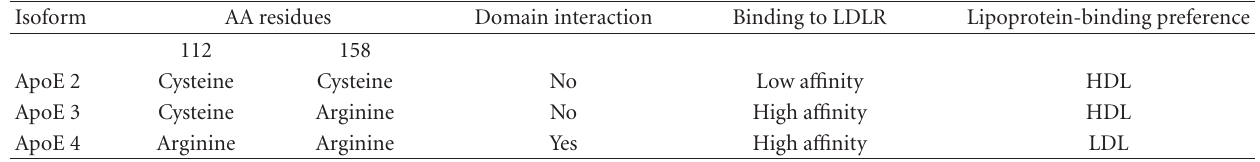
Figure 2: The synthesis and secretion of apoE. Hepatic parenchymal cells are the principal apoE producing cells, presumably accounting for 60% to 75% of apoE in plasma, followed by astrocytes, which are the main apoE producing cells in the nervous system. ApoE mRNA can also be found in spleen, lung, kidney, peripheral nerves, muscular tissue, adrenal, ovary and testis, and so forth. In the nervous system, apoE mRNA is present in astrocytes, nonmyelinating Schwann cells, ependymal cells, microglia, and neurons, and so forth. BCs denotes blood cells; PNS denotes peripheral nervous system; CSF denotes cerebrospinal fluid. Table 1: The main di ff erences among human apoE